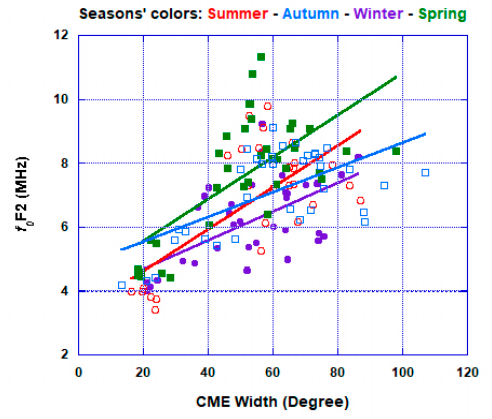
Figure 7. The seasonal variation of the monthly average f 0 F2 as a response to the monthly average CME width variation. The season points and its fitting line are colorized as in the figure’s caption of each season word’s color.